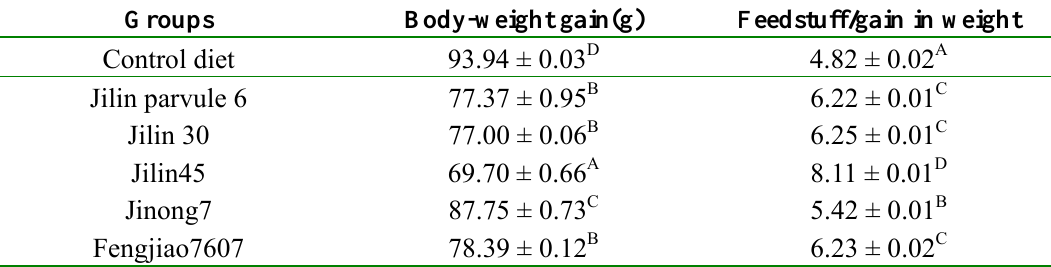
Table 3. Body-weight gain of rat and feed conversion ratio.